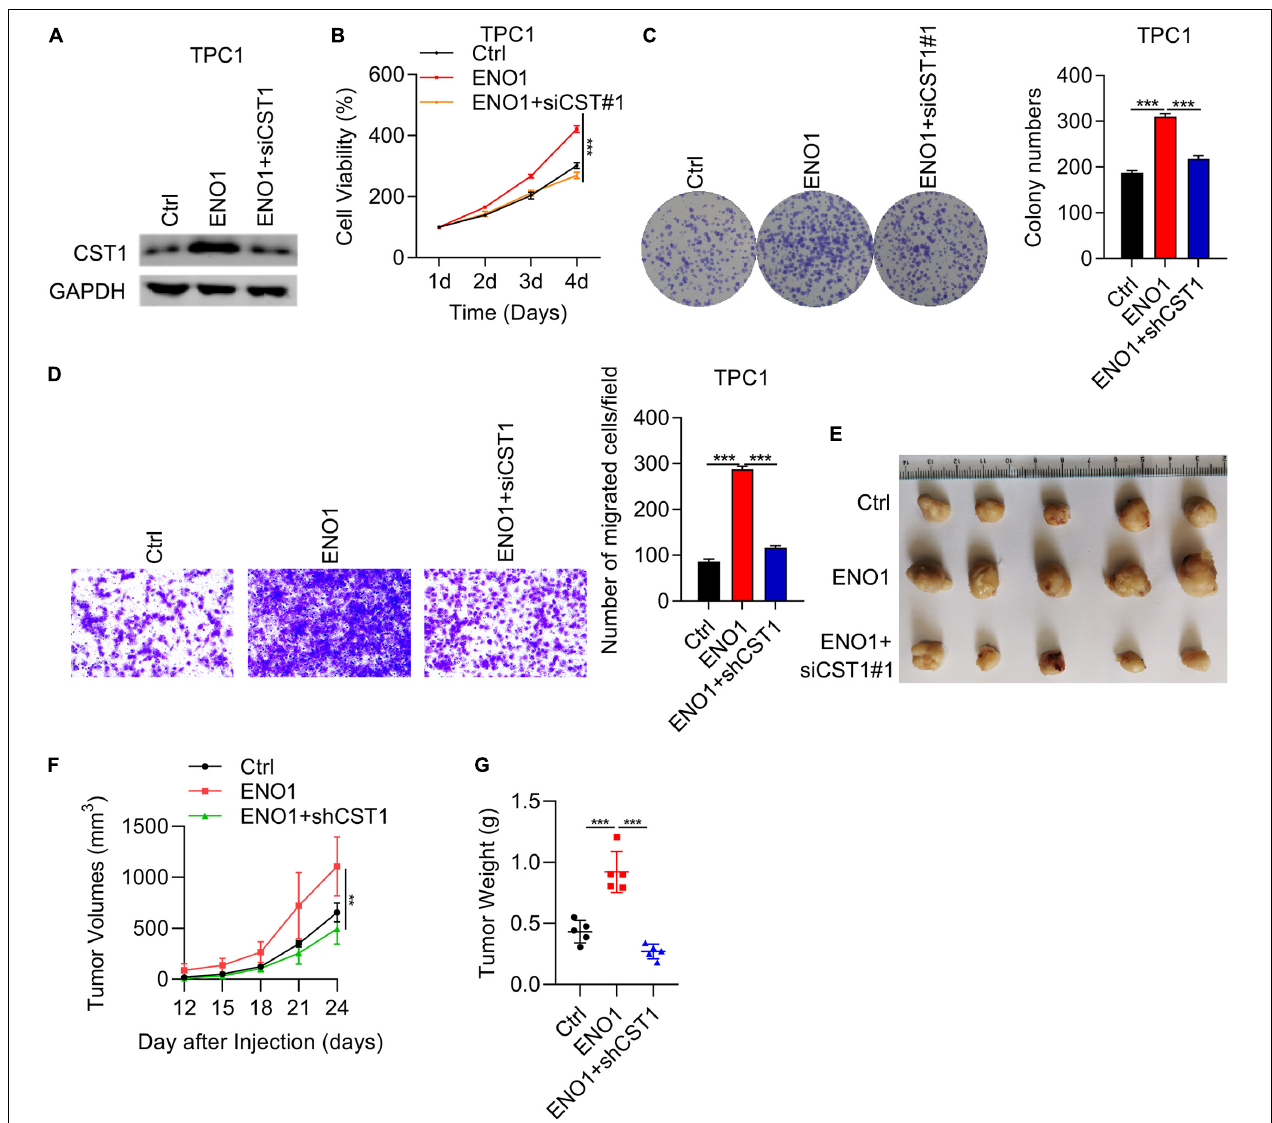
FIGURE 8 | Proliferation, invasion, and tumorigenicity enhanced by ENO1 overexpression is attenuated by CST1 depletion. (A) Western blot analysis of CST1 in TPC1 cells transfected with control, ENO1, and ENO1+shCST1. GAPDH was used as a loading control. (B) CCK8 cell viability analysis of TPC1 cells transfected with control, ENO1, and ENO1+shCST1. *** P < 0.001. (C) Colony formation analysis of TPC1 cells transfected with control, ENO1, and ENO1+shCST1. *** P < 0.001. (D) Invasion ability analysis of TPC1 cells transfected with control, ENO1, and ENO1+shCST1. *** P < 0.001. (E–G) Tumor formation analysis in athymic nude mice ( n = 5) injected with TPC1 cell lines expressing control, ENO1, and ENO1+shCST1. Representative image (E) , tumor growth curve (F) and tumor (G) weight of xenografted tumors are shown. ** P < 0.01; *** P <